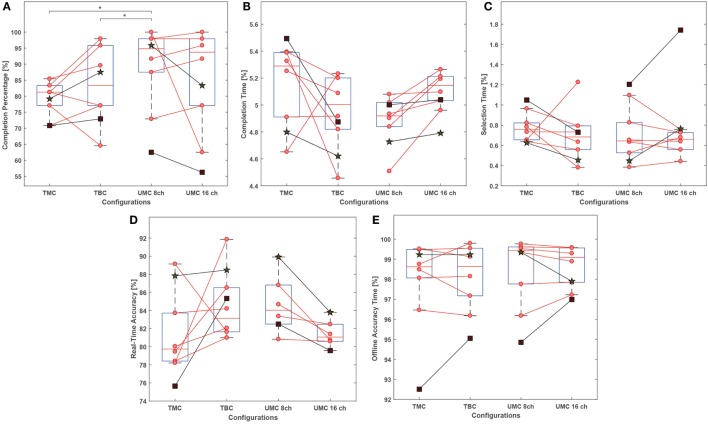
Box plots presenting the results of the comparison of the three electrode configurations in terms of real-time metrics relative [i.e., (A) completion percentage, (B) completion time, (C) selection time, (D) real-time accuracy] and (E) offline accuracy. The boxplots represent only the data relative to non-amputated subjects. The line in the center of the boxes indicates the location of the median, the upper edge indicates the third quartile, the bottom edge represents the first quartile, and the whiskers indicate the data range. Along with every boxplot, it is possible to the mean value for each subject. Red dots represent non-amputees, while the square and a star marker represent the data points for the transtibial and the transfemoral amputee subject, respectively. Statistical significance (p < 0.05) is marked by the *.